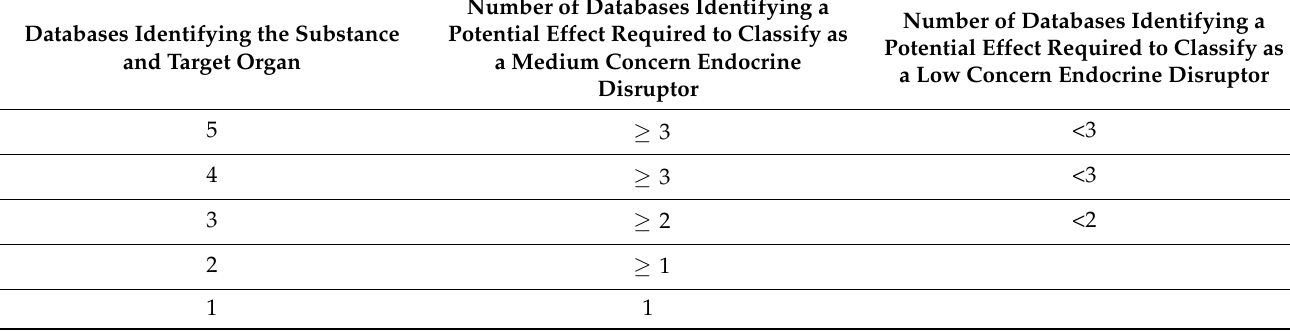
Databases Identifying the Substance and Target